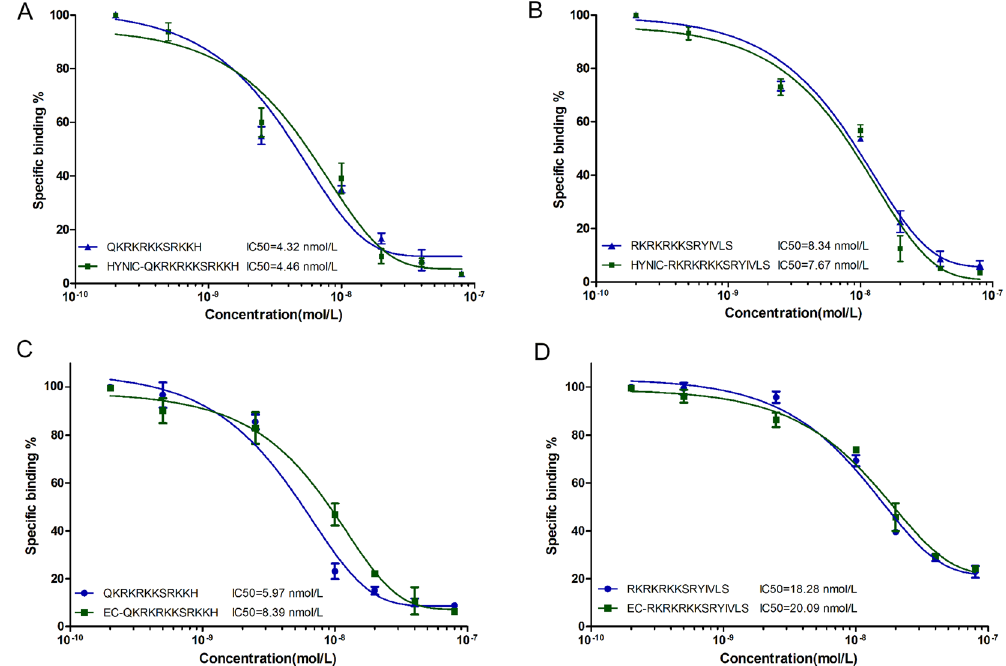
Figure 3. In vitro competitive receptor binding assays. The 99m Tc-labeled ( A , B ) and 188 Re-labeled peptides ( C , D ) were incubated with the corresponding non-labeled peptides. IC50s of the radiolabeled peptides were calculated after competed by corresponding peptides and HYNIC/EC conjugated